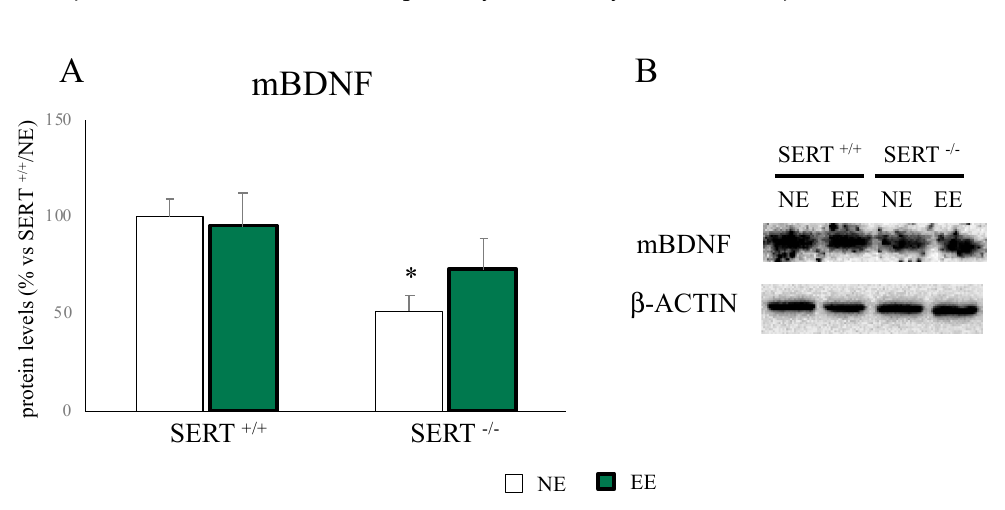
Figure 3. Analyses of mBDNF protein levels in the PFC of SERT +/+ and SERT − / − rats subjected to one month of exposure to NE (normal environment) or EE (environmental enrichment) ( A ) and its representative western blot bands ( B ). The data are presented as percent change of SERT +/+ / NE and are expressed as mean ± standard error of the mean (SEM). * p < 0.05, vs. SERT +/+ / NE; two-way ANOVA with PLSD.